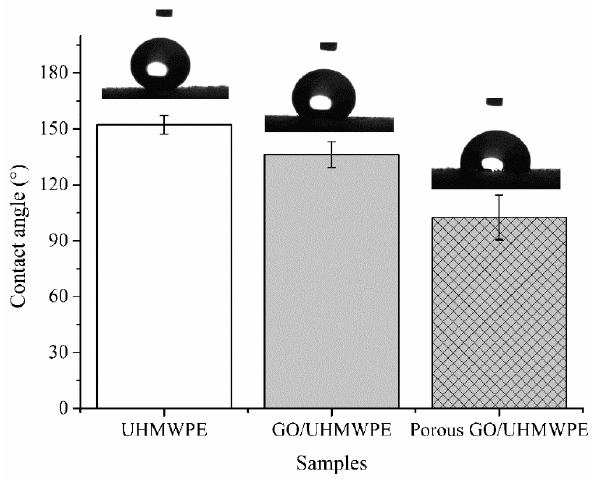
Figure 7. Contact angle of UHMWPE, GO/UHMWPE with GO 1 wt.% and surface porous GO/NaCl/UHMWPE composites with 1 wt.% GO and 10 wt.% NaCl.